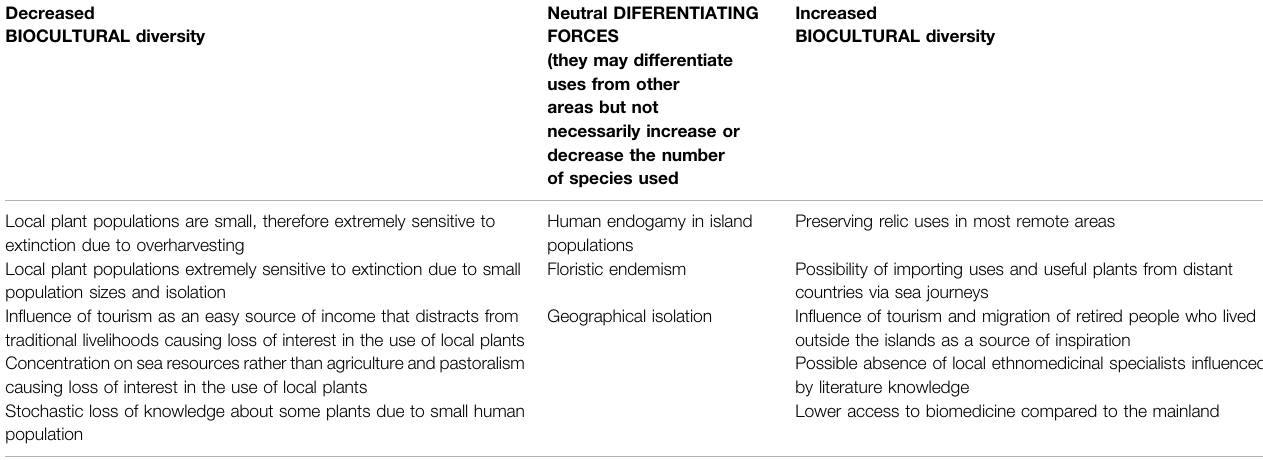
TABLE 6 | Hypothetical driving forces of island pharmacopoeias for further